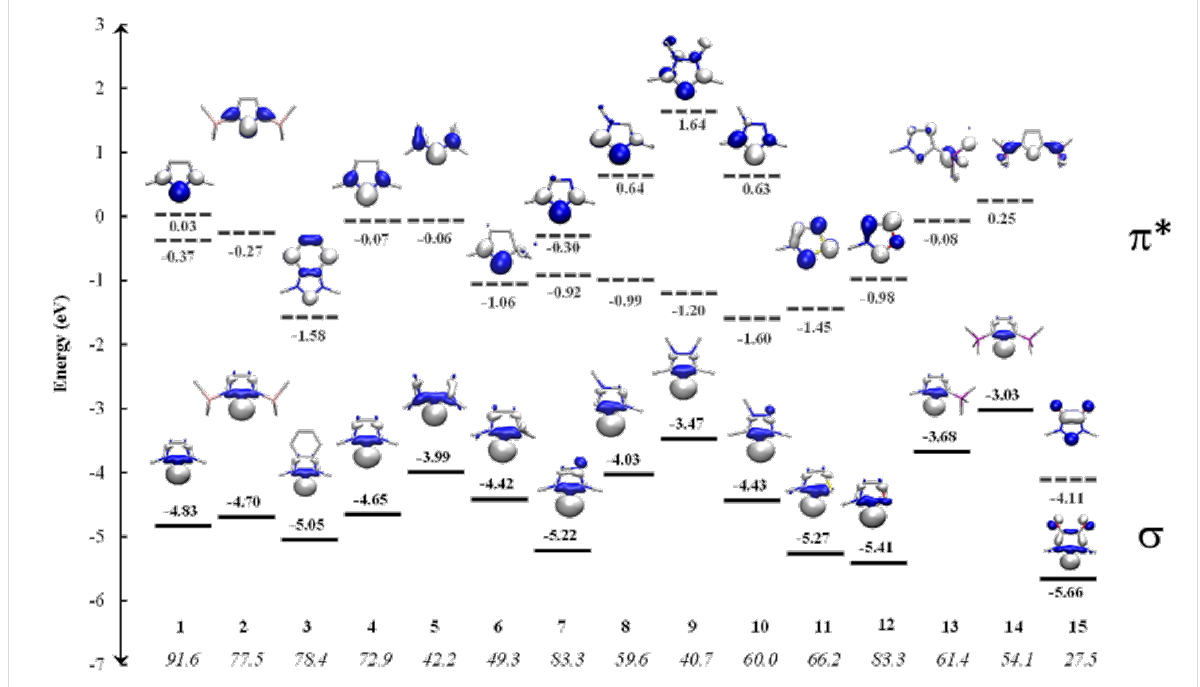
Figure 2: Frontier orbitals (BP86/def2-TZVPP) and eigenvalues (in eV) of the carbenes 1–15 . The isosurfaces were taken at the 0.06 isovalue. The hydrogen atoms are omitted for clarity.